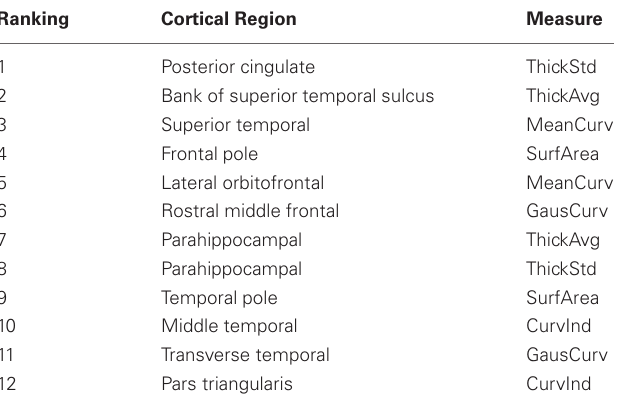
Regions from the Freesurfer structural analysis for the NYU site that were included in the classification. ThickStd: cortical region thickness standard devi- ation, ThickAvg: cortical region thickness average, SurfArea: cortical region surface area, MeanCurv: cortical region mean curvature, GausCurv: cortical region Gaussian curvature, CurvInd: cortical region curvature index.